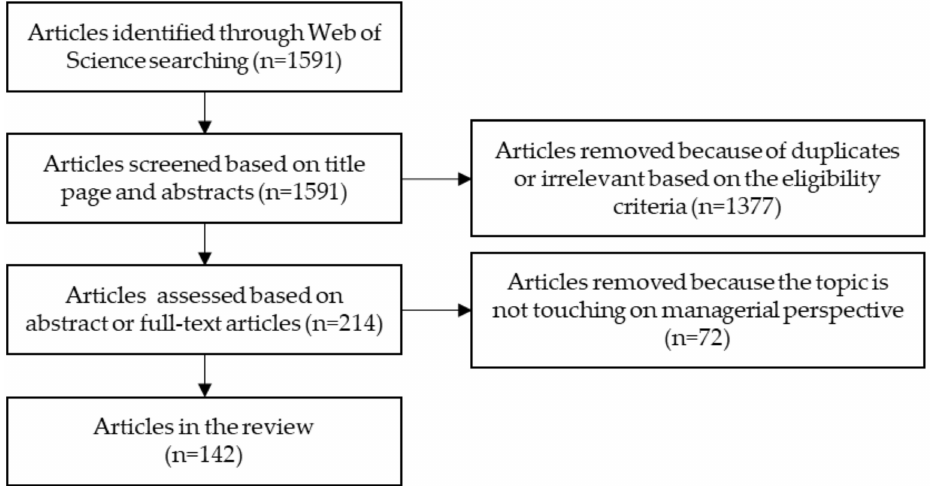
Figure 1. PRISMA Flowchart for database searches and retaining